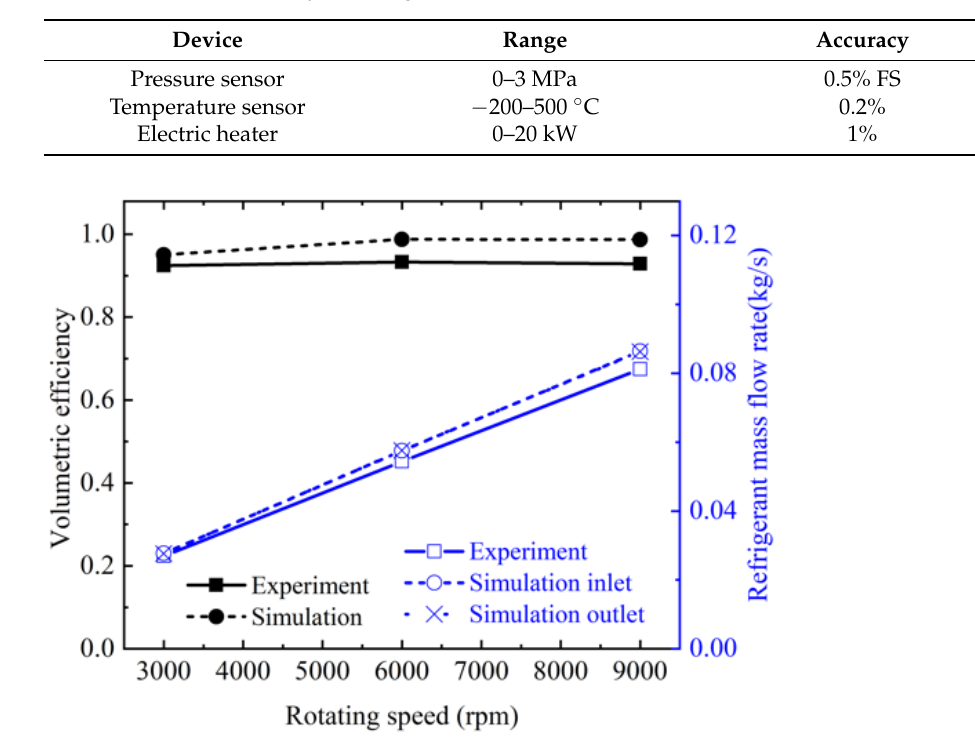
Figure 6. Device layout for the compressor test system. Table 4. Measured accuracy and range of the main test device.